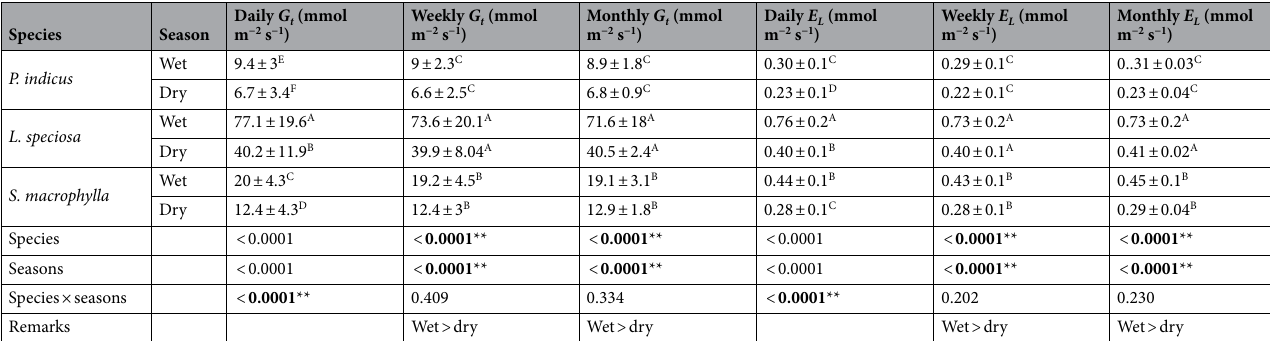
Table 2. Mean stomatal sensitivity along with mean daily, weekly and monthly G t and E L (± SD) for the three investigated species during the wet and the dry season. The same alphabetical superscript indicates no significant difference from each other and vice versa at 5% significant level. P -values in bold and having ** indicate a statistically significant difference between means of the main factors and the interaction between the main factors.